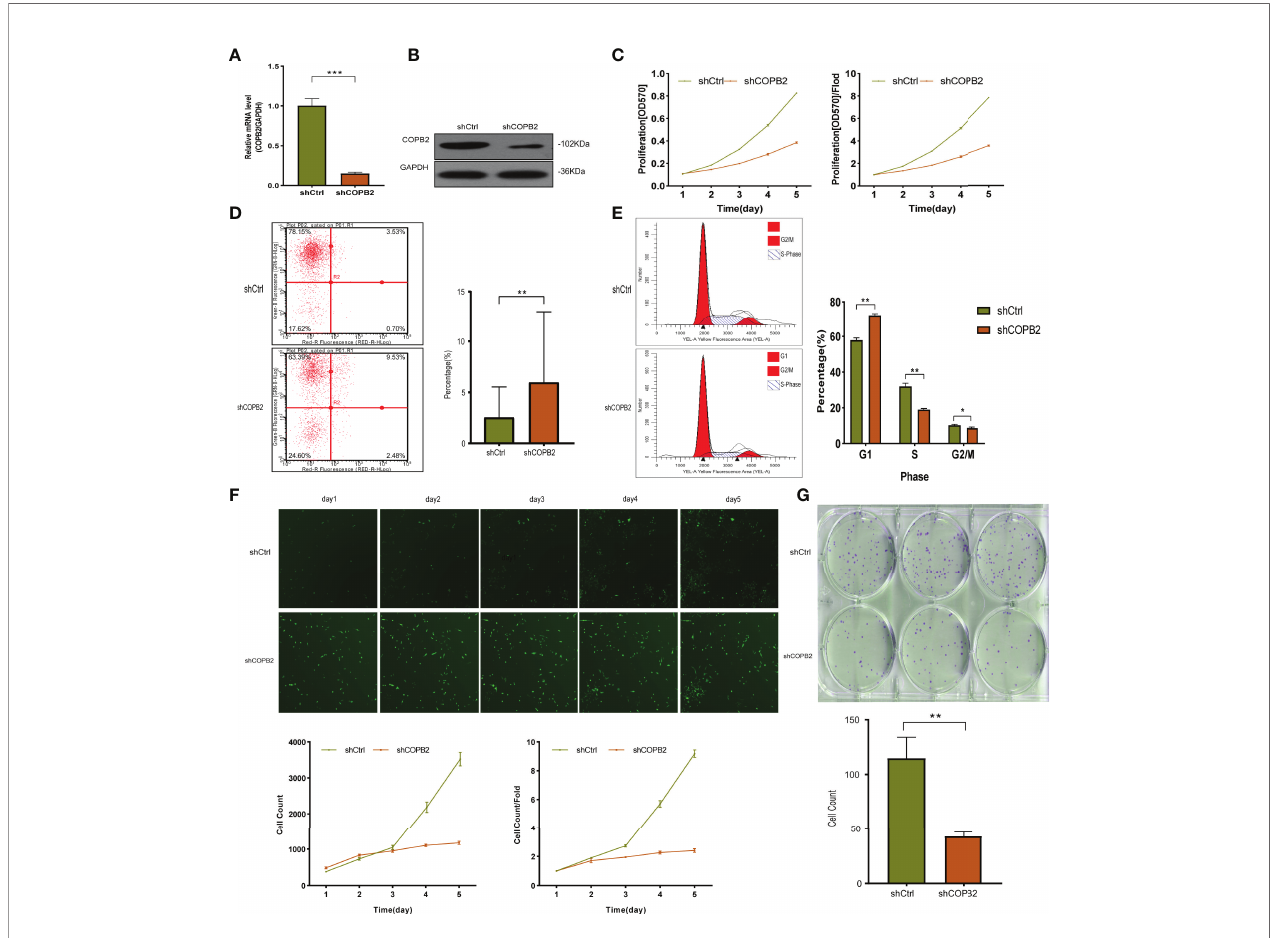
FIGURE 2 | The function of COPB2 protein in DU-145 cell line. (A) Identi fi cation of COPB2 knockdown ef fi ciency using shCOPB2 by qRT-PCR. (B) Western blot analysis of COPB2 protein expression in shCtrl and shCOPB2 groups. (C) Cell proliferation was assessed in shCtrl and shCOPB2 groups using MTT assays. (D) Cell apoptosis: FCM showed that the shCOPB2 increased cell apoptosis compared with the shCtrl group. (E) Cell cycle: FCM analysis shCOPB2 induced a G1-phase arrest. An obvious increase in the G1-phase cell population and a signi fi cant decrease in the S-phase and G2-phase cell population were observed compared with the shCtrl group. (F) Cell proliferation was signi fi cantly inhibited in shCOPB2 group compared with shCtrl group according to GFP-based Cellomics Array Scan VTI imaging. (G) Colony-formation analysis by light microscopy. After lentiviral transfection of DU-145 cells, the shCOPB2 group displayed a signi fi cantly reduced number of cell colonies compared with the shCtrl group. * P < 0.05, ** P < 0.01, *** P <